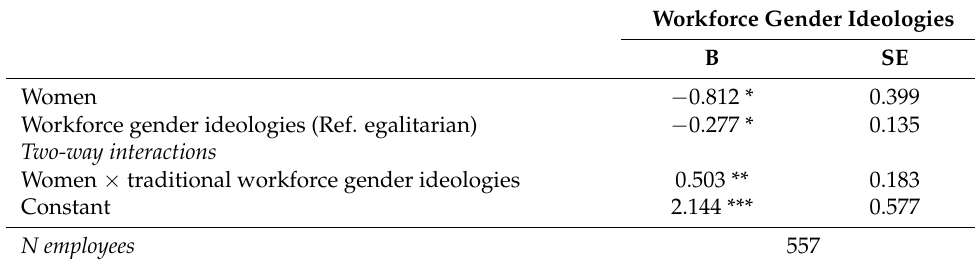
Table 4. The results of linear regression models, estimating the association of gender with workforce gender ideologies in relation to employees’ unmet expectations.